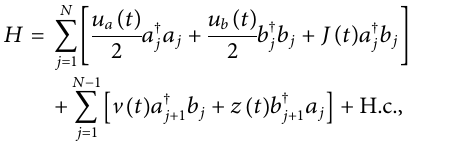
Frontiers in Physics |